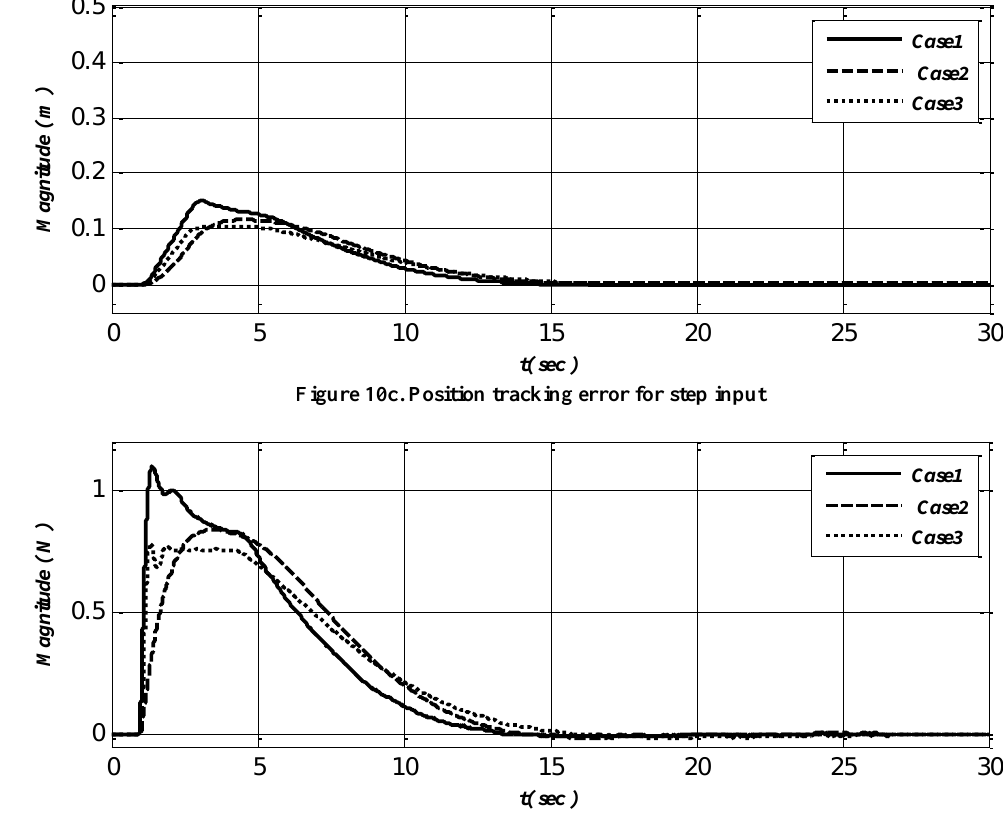
Figure 11a. Master controller signal for step input ( f m )